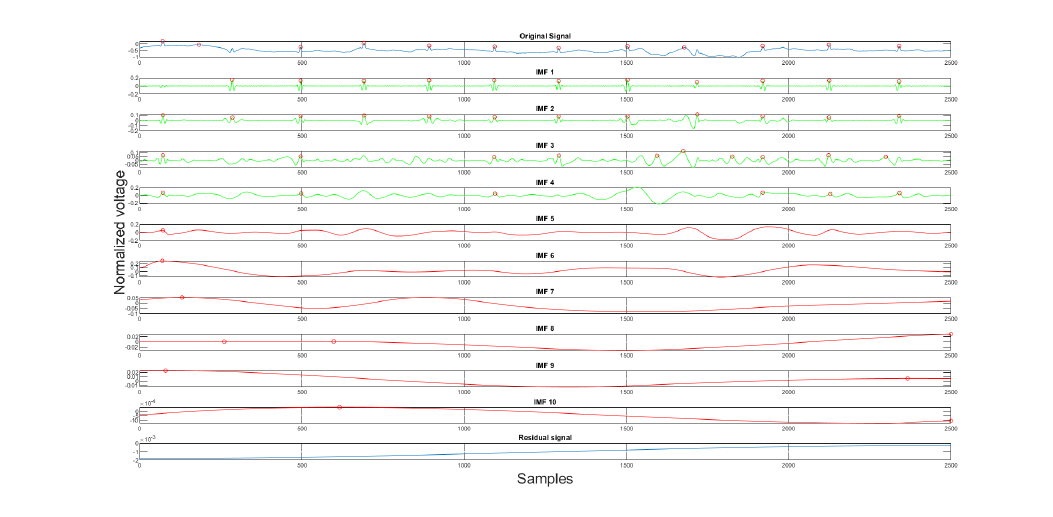
Figure 8. The original signal, clean IMFs, noisy IMFs and